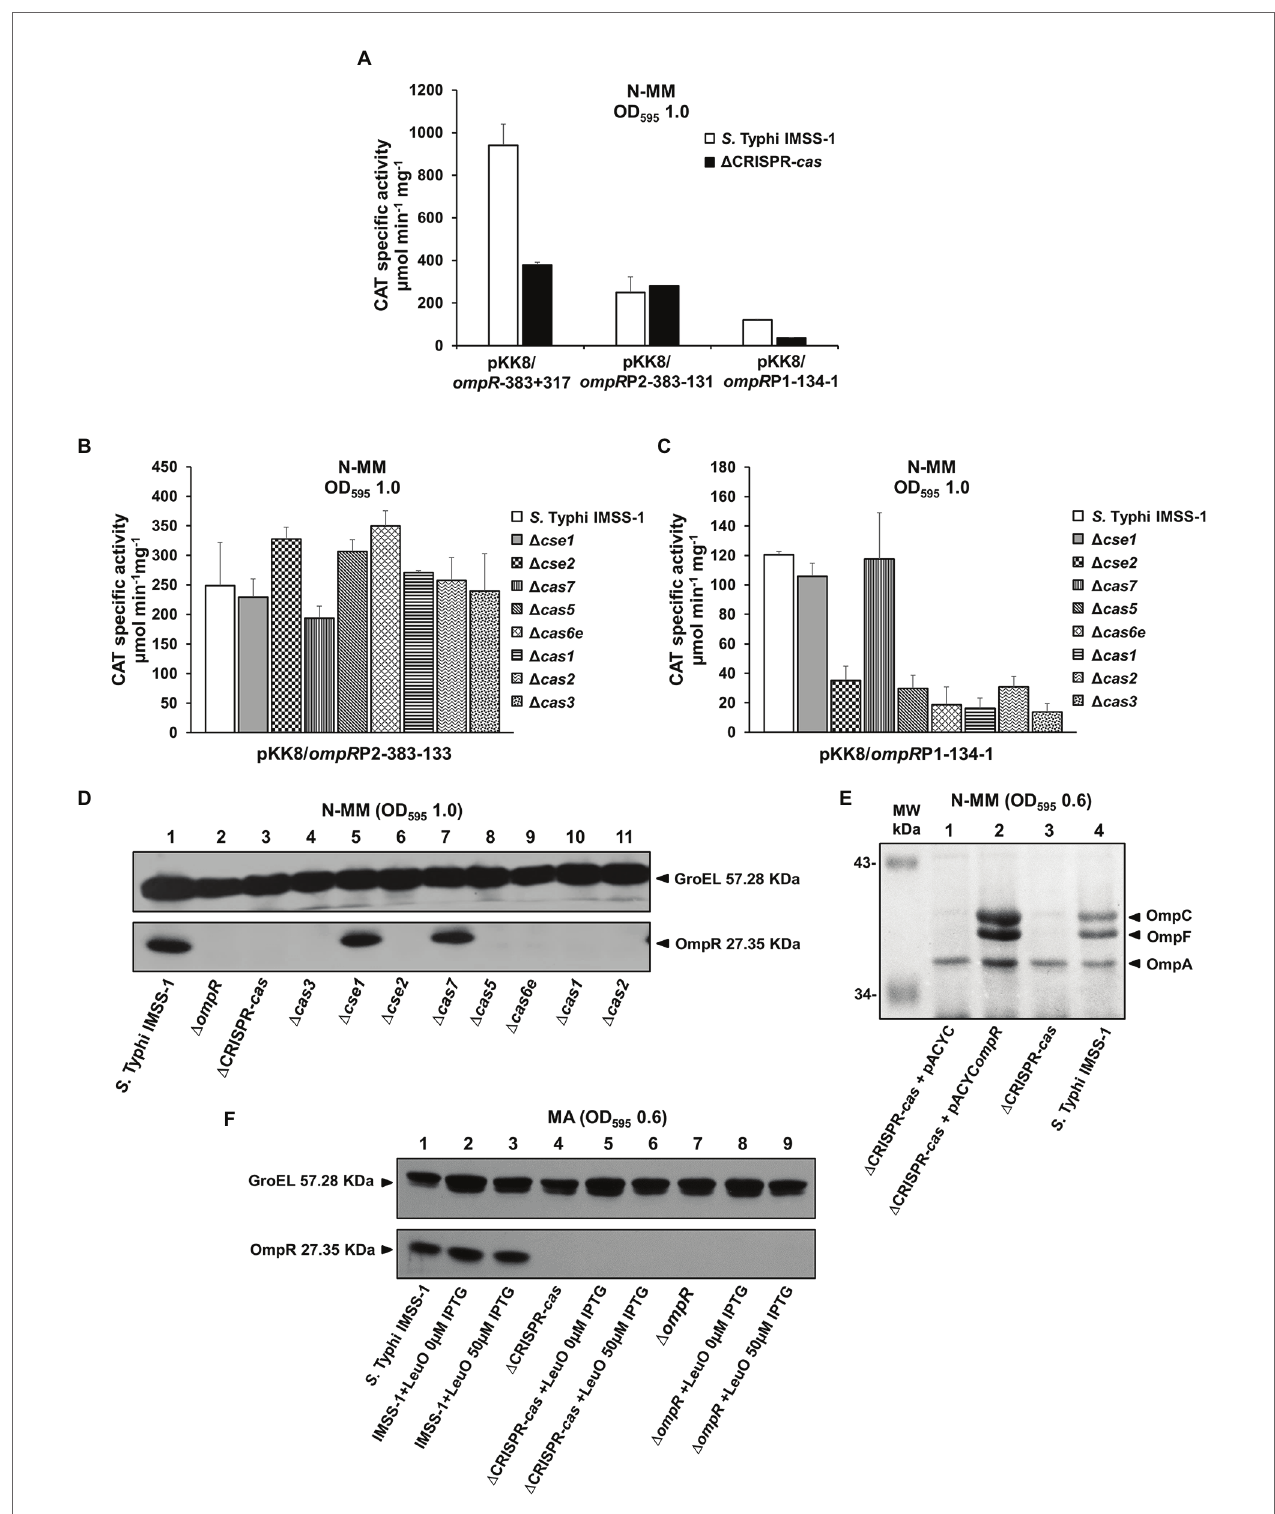
FIGURE 4 | CRISPR-Cas is involved in the genetic control of OmpR. (A) Transcriptional profiles of Salmonella Typhi IMSS-1 and Salmonella Typhi IMSS-1 Δ CRISPR- cas ( Δ CRISPR- cas ) harboring plasmids pKK8/ ompR -383 + 317, pKK8/ ompR P2-383-133 ( ompR P2) or pKK8/ ompR P1-134-1 ( ompR P1), grown